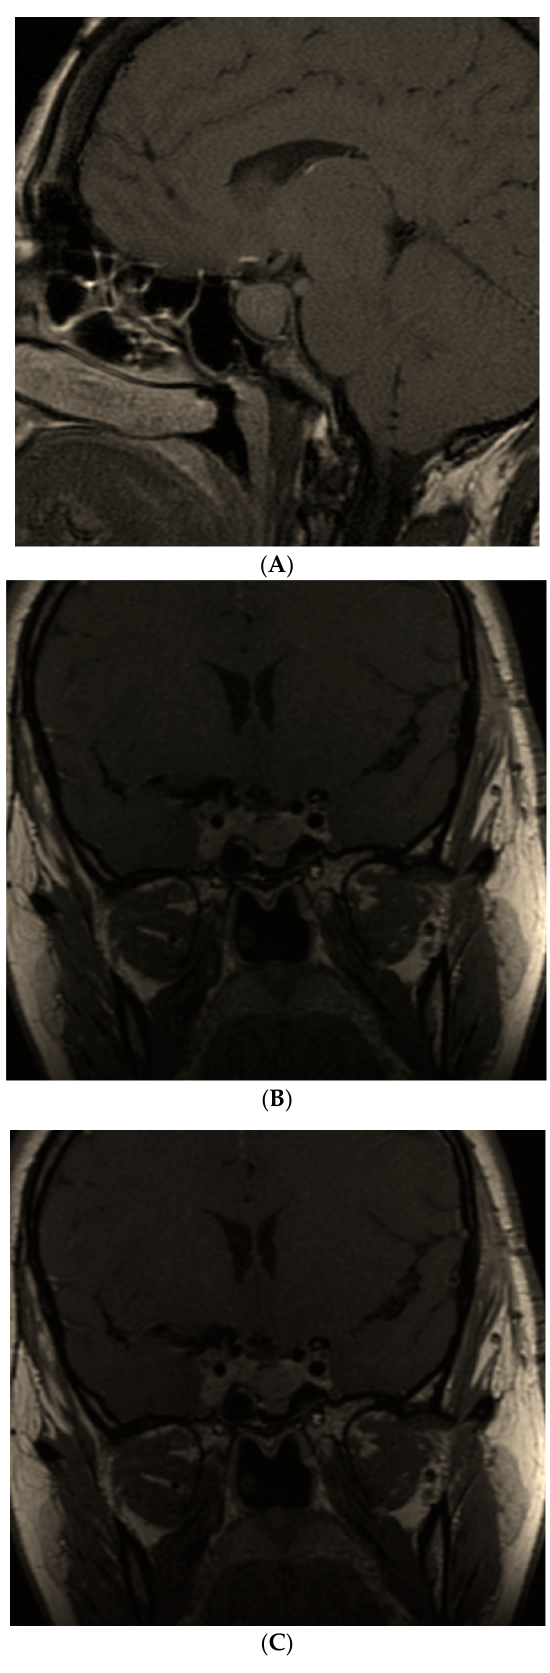
Figure 4. Magnetic resonance imaging of the somatotropinoma during follow-up. ( A ) Before second pituitary surgery (5 years postpartum)—a somatotropinoma of 3.8 by 0.8 by 1.1 cm, with superior and right extension and invasion at the level of cavernous sinus. ( B ) During follow-up: 2 months since second neurosurgery—a pituitary macroadenoma of 2.8 by 0.8 by 1.0 cm with right cavernous sinus invasion. ( C ) The most recent evaluation under triple medical therapy—6 years since the second pituitary intervention (status quo versus 3.B.)